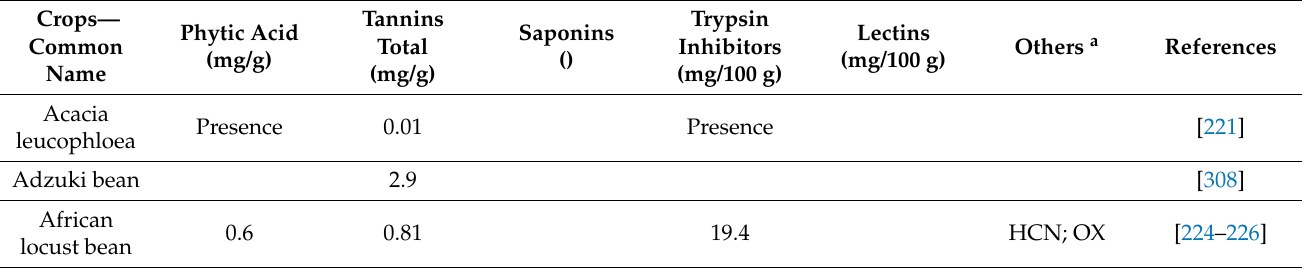
Table A4. Antinutritional constituents of pulses and other crops with high protein content, in grey major